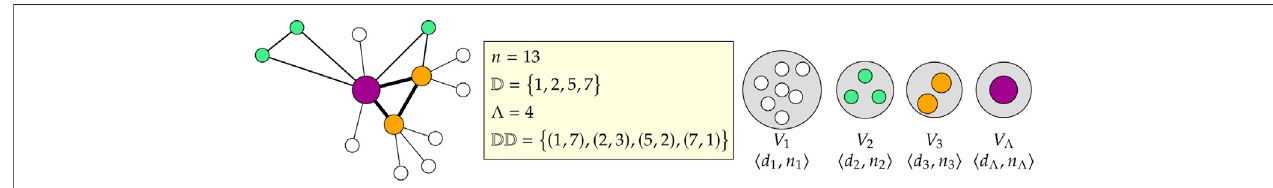
FIGURE 1 | Illustrative example of the input and preprocessing for a desired graph with n (cid:1) 13 vertices.